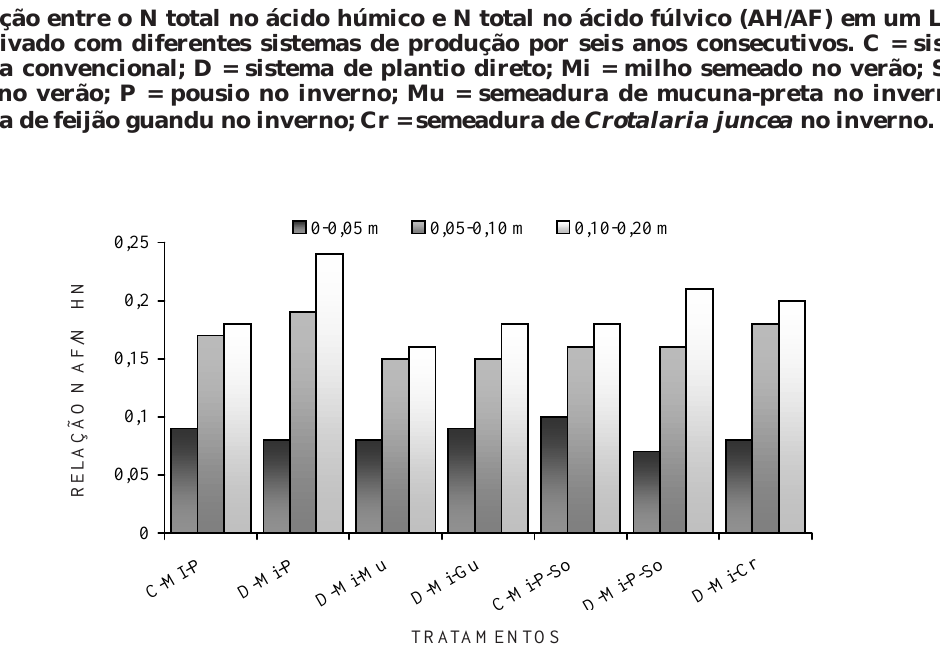
Figura 5. Relação entre o N total no ácido fúlvico e N total na humina (AF/HN) em um Latossolo Roxo cultivado com diferentes sistemas de produção por seis anos consecutivos. C = sistema de semeadura convencional; D = sistema de plantio direto; Mi = milho semeado no verão; So = soja semeada no verão; P = pousio no inverno; Mu = semeadura de mucuna-preta no inverno; Gu = semeadura de feijão guandu no inverno; Cr = semeadura de Crotalaria juncea no